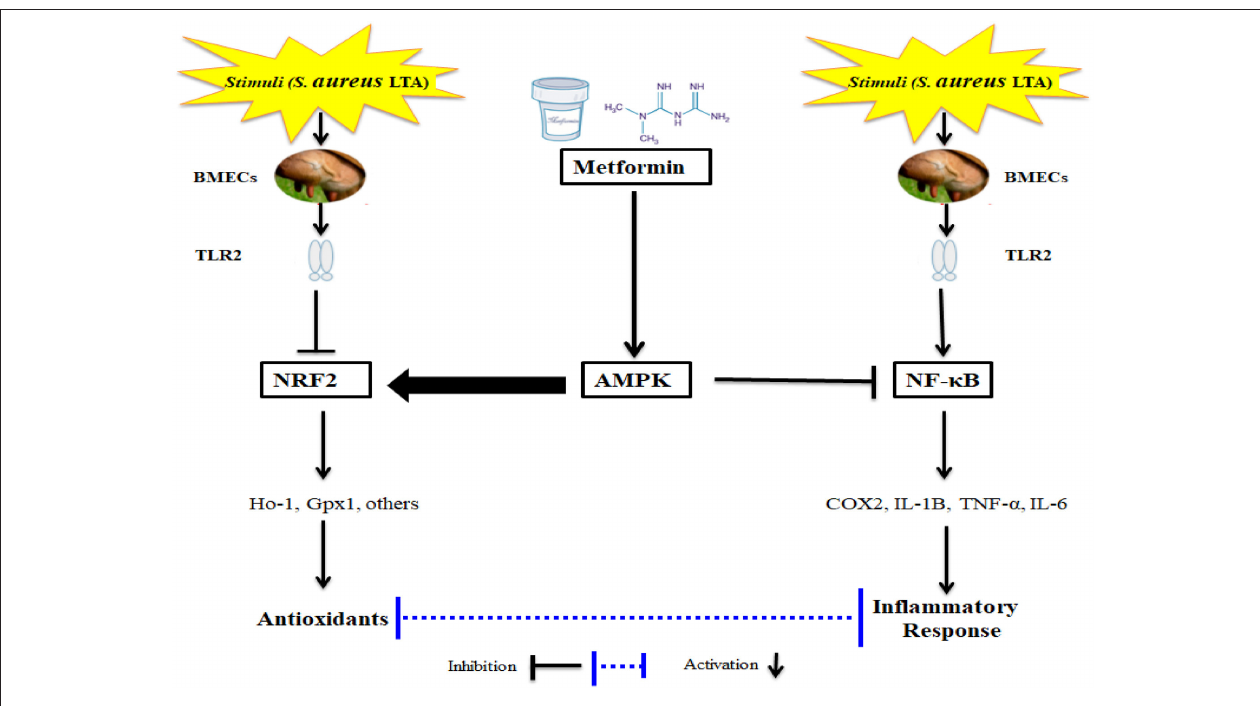
FIGURE 6 | Schematic Representations of Metformin and